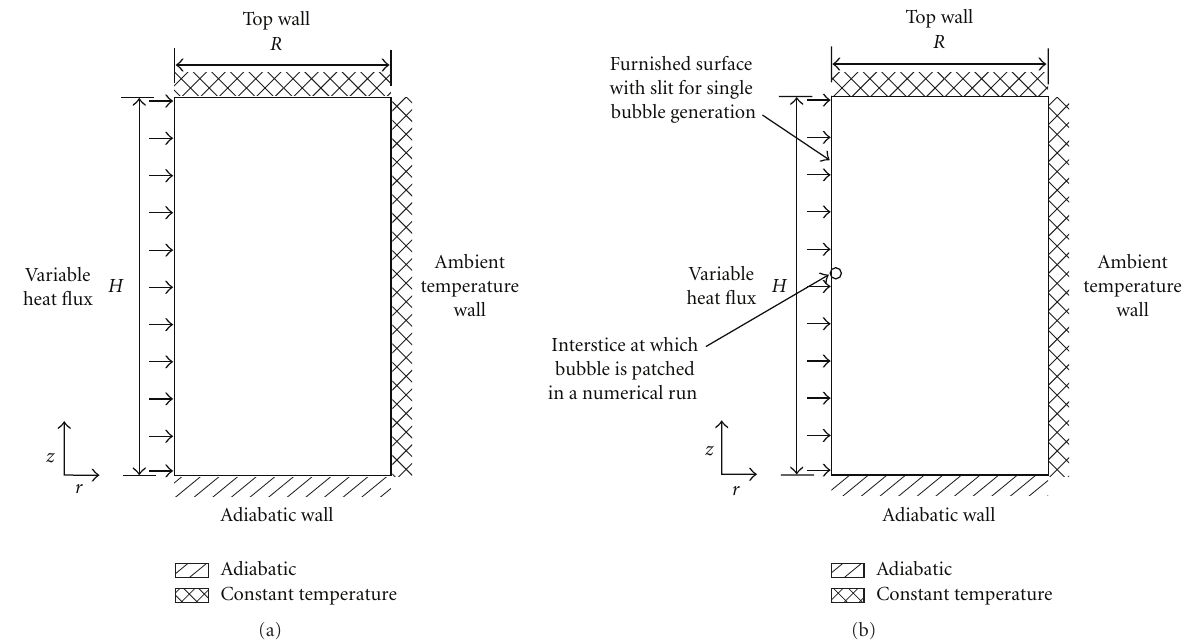
Figure 1: (a) Schematic of a dimensionless rectangular enclosure with leftside wall heated. (b) Schematic of a vertical rectangular enclosure with leftside wall heated and a bubble patched at the interstice.